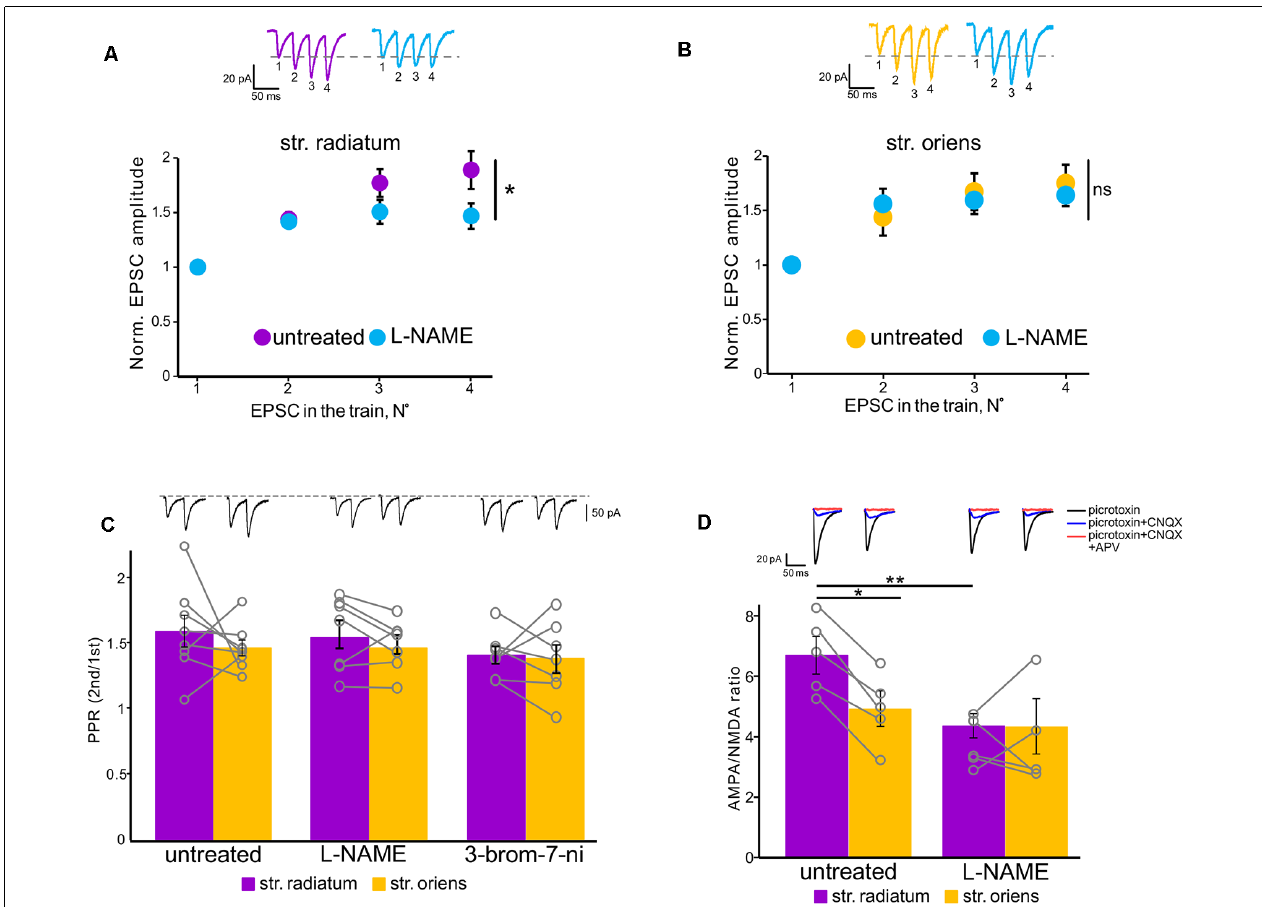
FIGURE 5 | NOS inhibition affected polyamine-dependent facilitation in the apical but not basal dendrites. (A) Facilitation at apical dendrites recorded with spermine-containing intracellular solution in untreated cells (purple, n = 6 cells from four animals) and under NOS blockade (orange, n = 6 cells from four animals). * p ≤ 0.05. Top, example traces. (B) Basal dendrite responses recorded with spermine-containing intracellular solution in untreated cells (purple, n = 7 cells from four animals) and under NOS blockade (orange, n = 7 cells from four animals). Top, example traces. EPSC numbering corresponds to the x-axis of each graph. ns, nonsignificant. (C) Comparison of paired-pulse ratios in stratum radiatum (purple) and stratum oriens (orange) in untreated cells and under NOS blockade (control: n = 8 cells from five animals; L-NAME: n = 7 cells from three animals; 3-bromo-7-ni: n = 7 cells from three animals). Open gray circles represent individual data points. Top, example traces. (D) Comparison of AMPA-NMDA ratios in stratum radiatum (purple) and stratum oriens (orange) in untreated cells ( n = 5 cells from three animals) and under NOS blockade ( n = 5 cells from three animals). Top, example traces. * p ≤ 0.05, ** p ≤